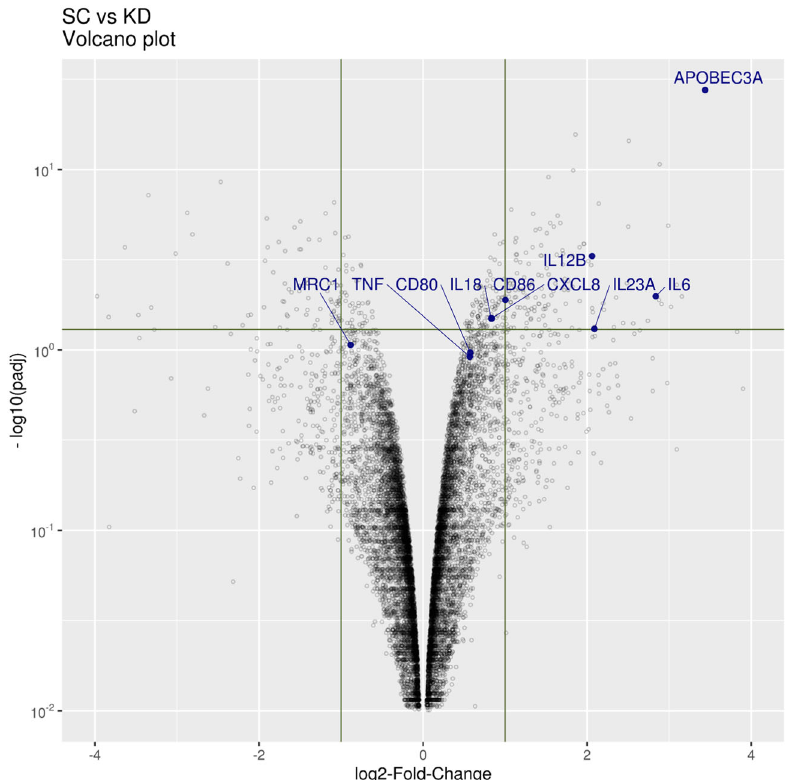
Fig. 5 A3A augments in fl ammatory gene expression in M1-polarized macrophages. Volcano plot of SC vs. A3A KD macrophages highlight selected in fl ammatory genes. Positive log2FC values represent enriched expression in SC and negative values enriched in KD. Plot highlights that A3A expression is signi fi cantly enriched in SC relative to KD, indicating effective knockdown and that A3A is required for high expression levels of pro-in fl ammatory genes IL6 , IL23A , IL12B and CD86 in M1 macrophages. Vertical lines indicate absolute 2-fold-change values and the horizontal line FDR = 0.05.